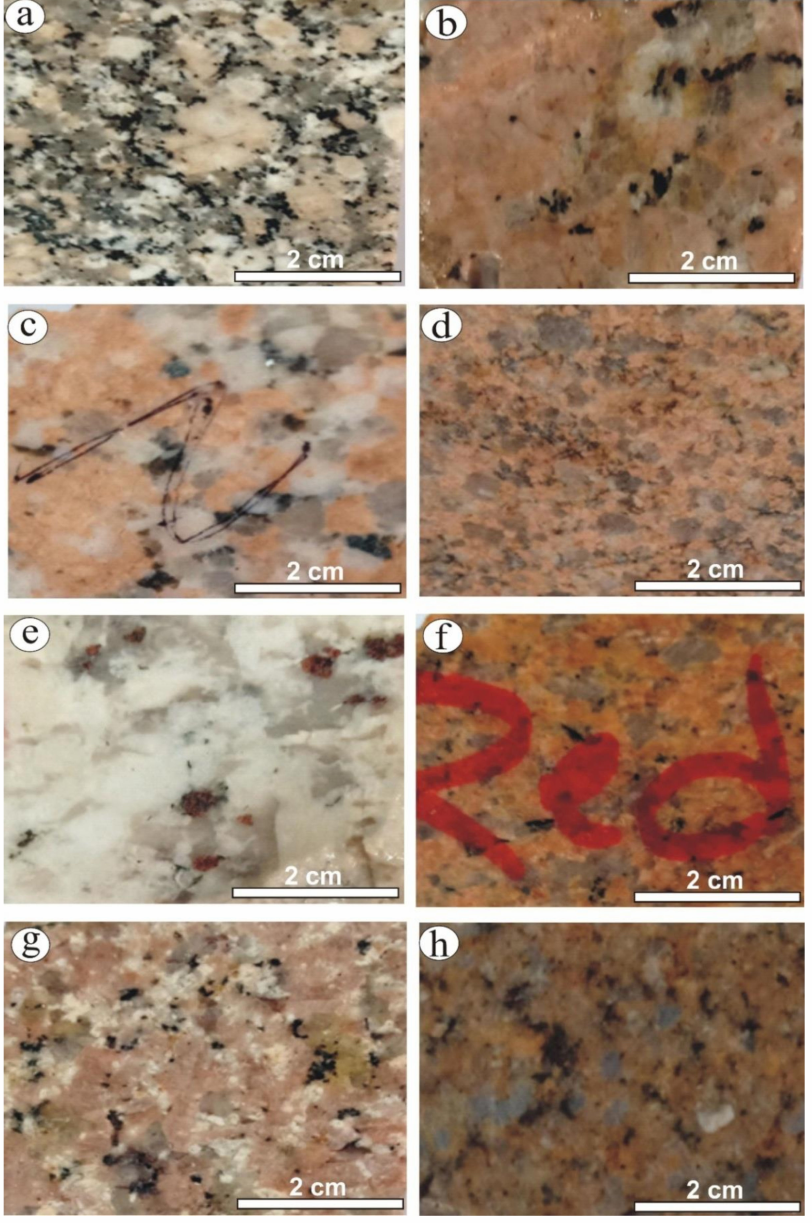
Figure 1. Photographs showing hand specimens of the granitic rock types: ( a ) Gandonna, ( b ) pink granite, ( c ) buff granite I, ( d ) buff granite II, ( e ) Fantazia, ( f ) red granite, ( g ) Rosa granite, ( h ) Qusseir